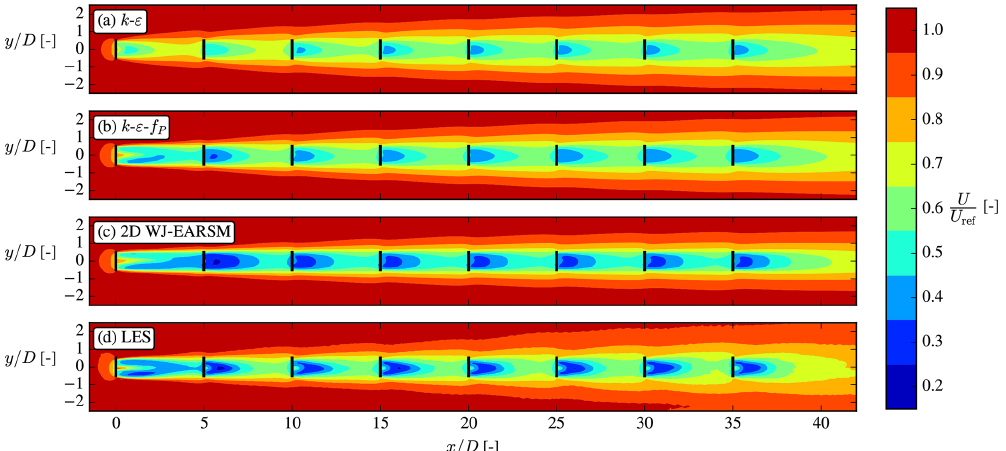
Figure 21. Streamwise velocity contour at hub height for the aligned-row TotalControl